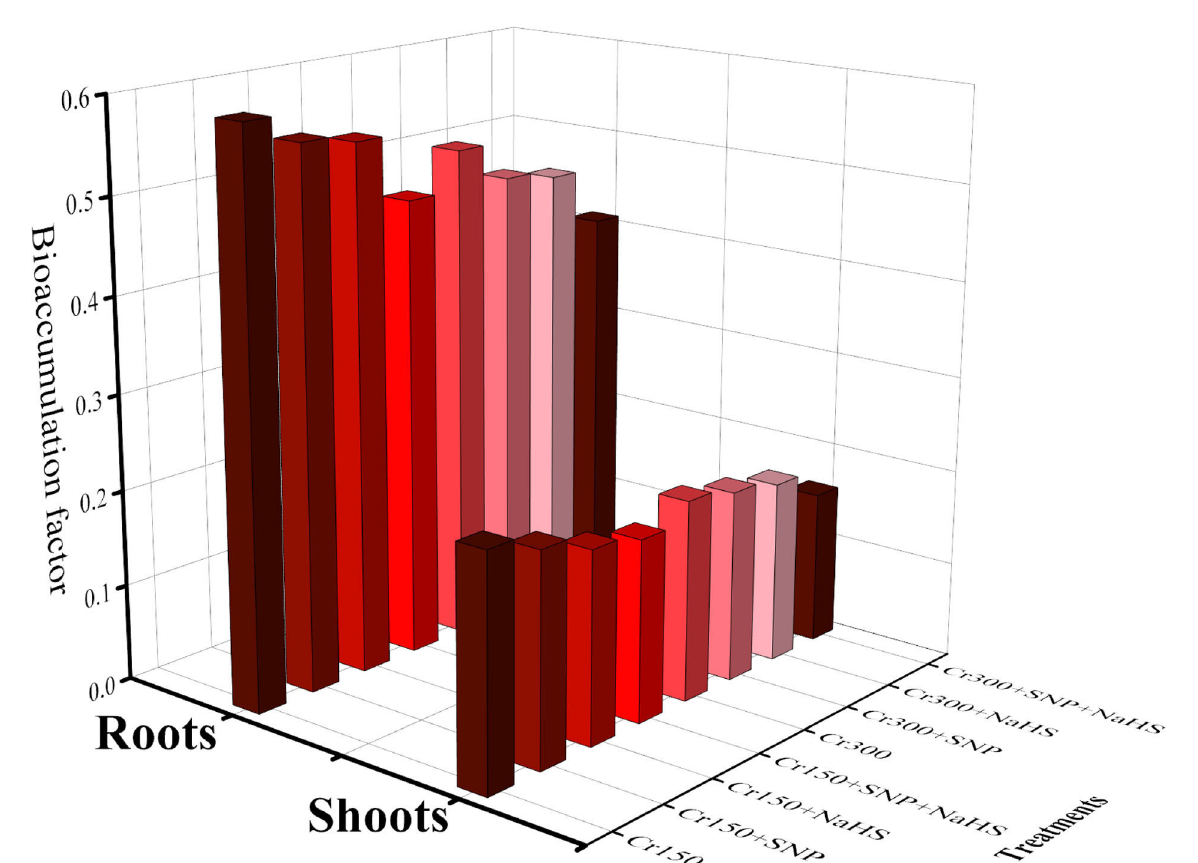
FIGURE7 Bioaccumulation factor of roots and shoots of spinach ( S. oleracea ) plants grown under the different levels of Cr stress, i.e., 150 and 300 µ M, in sandy loam soil with alone/or combinatorial application of SNP and